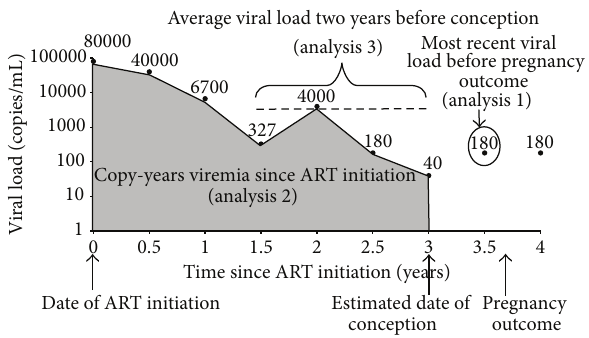
Figure 2: Construction of copy-years viremia, a calculation of the area under the longitudinal viral load curve from ART initiation to estimated date of conception (analysis 2). Also illustrated in the figure are the average viral load two years before conception (analysis 3), equivalent to copy-years viremia in two years before conception, and the most recent viral load measure proximal to pregnancy outcome (analysis